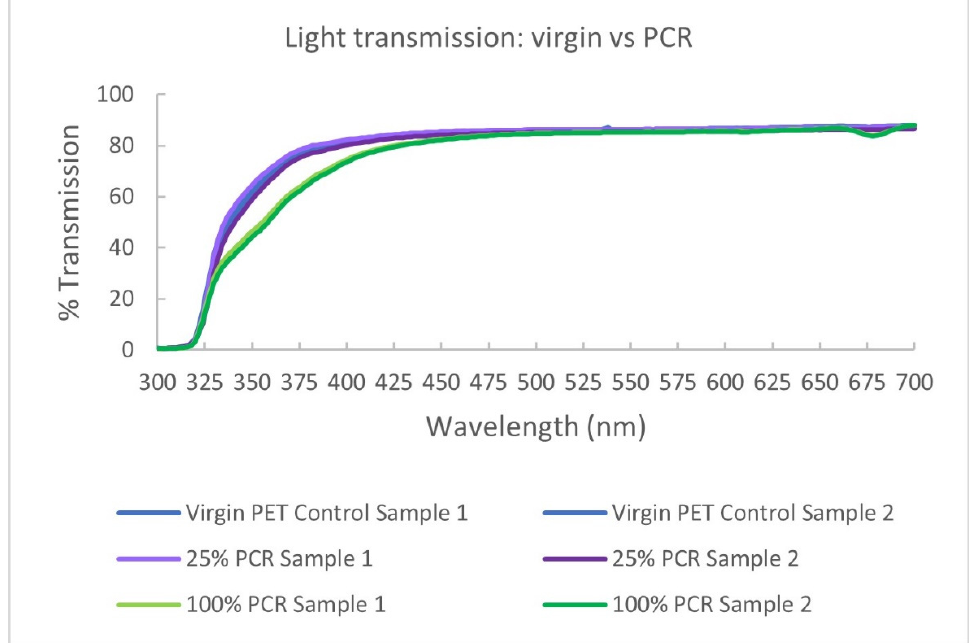
Figure 16. PCR impact on UV light transmission.